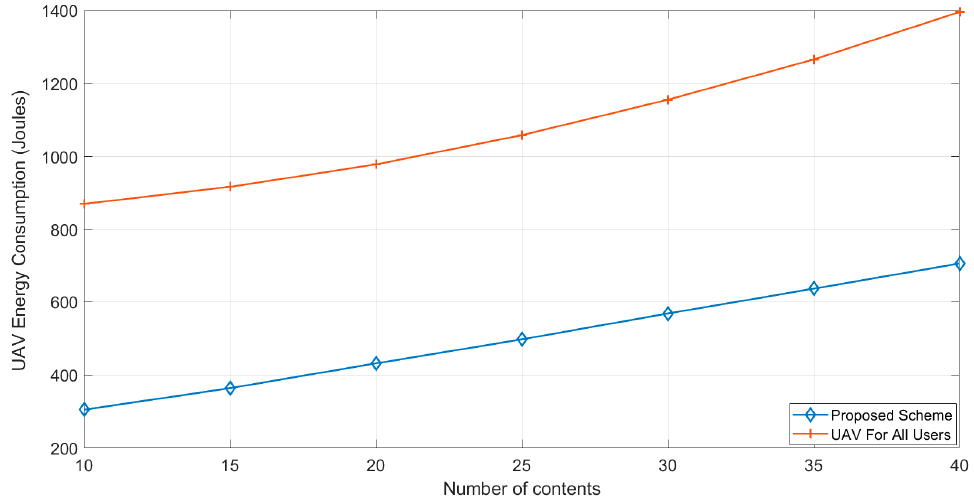
Figure 9. UAV energy consumption V/S number of users.